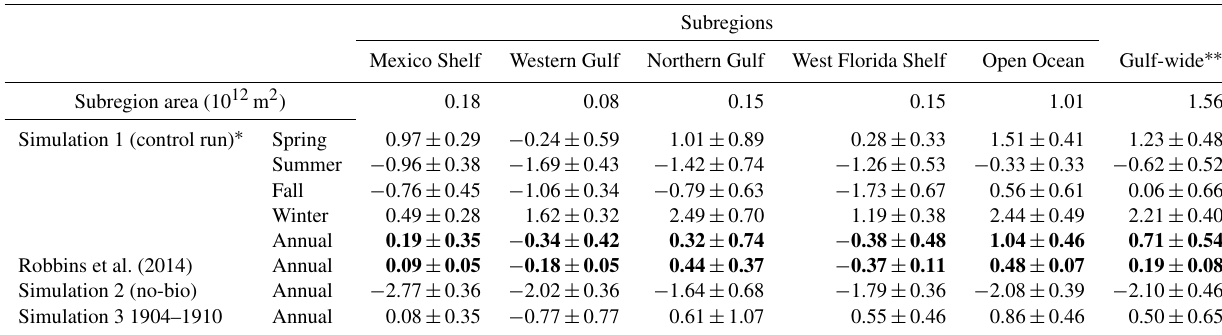
Figure 6. Time series of spatially averaged p CO 2 (control run in blue and no-biology run in red) (a) on the Northern Gulf of Mexico Shelf and (b) in the entire Gulf of Mexico, overlaid with in situ observations (in black) from Huang et al. (2015) and Takahashi et al. (2015). Table 1. Comparison between observed and modeled air–sea CO 2 flux. Observations are taken from Robbins et al. (2014), whereas the model results are 7-year (2005–2010) model means ∗